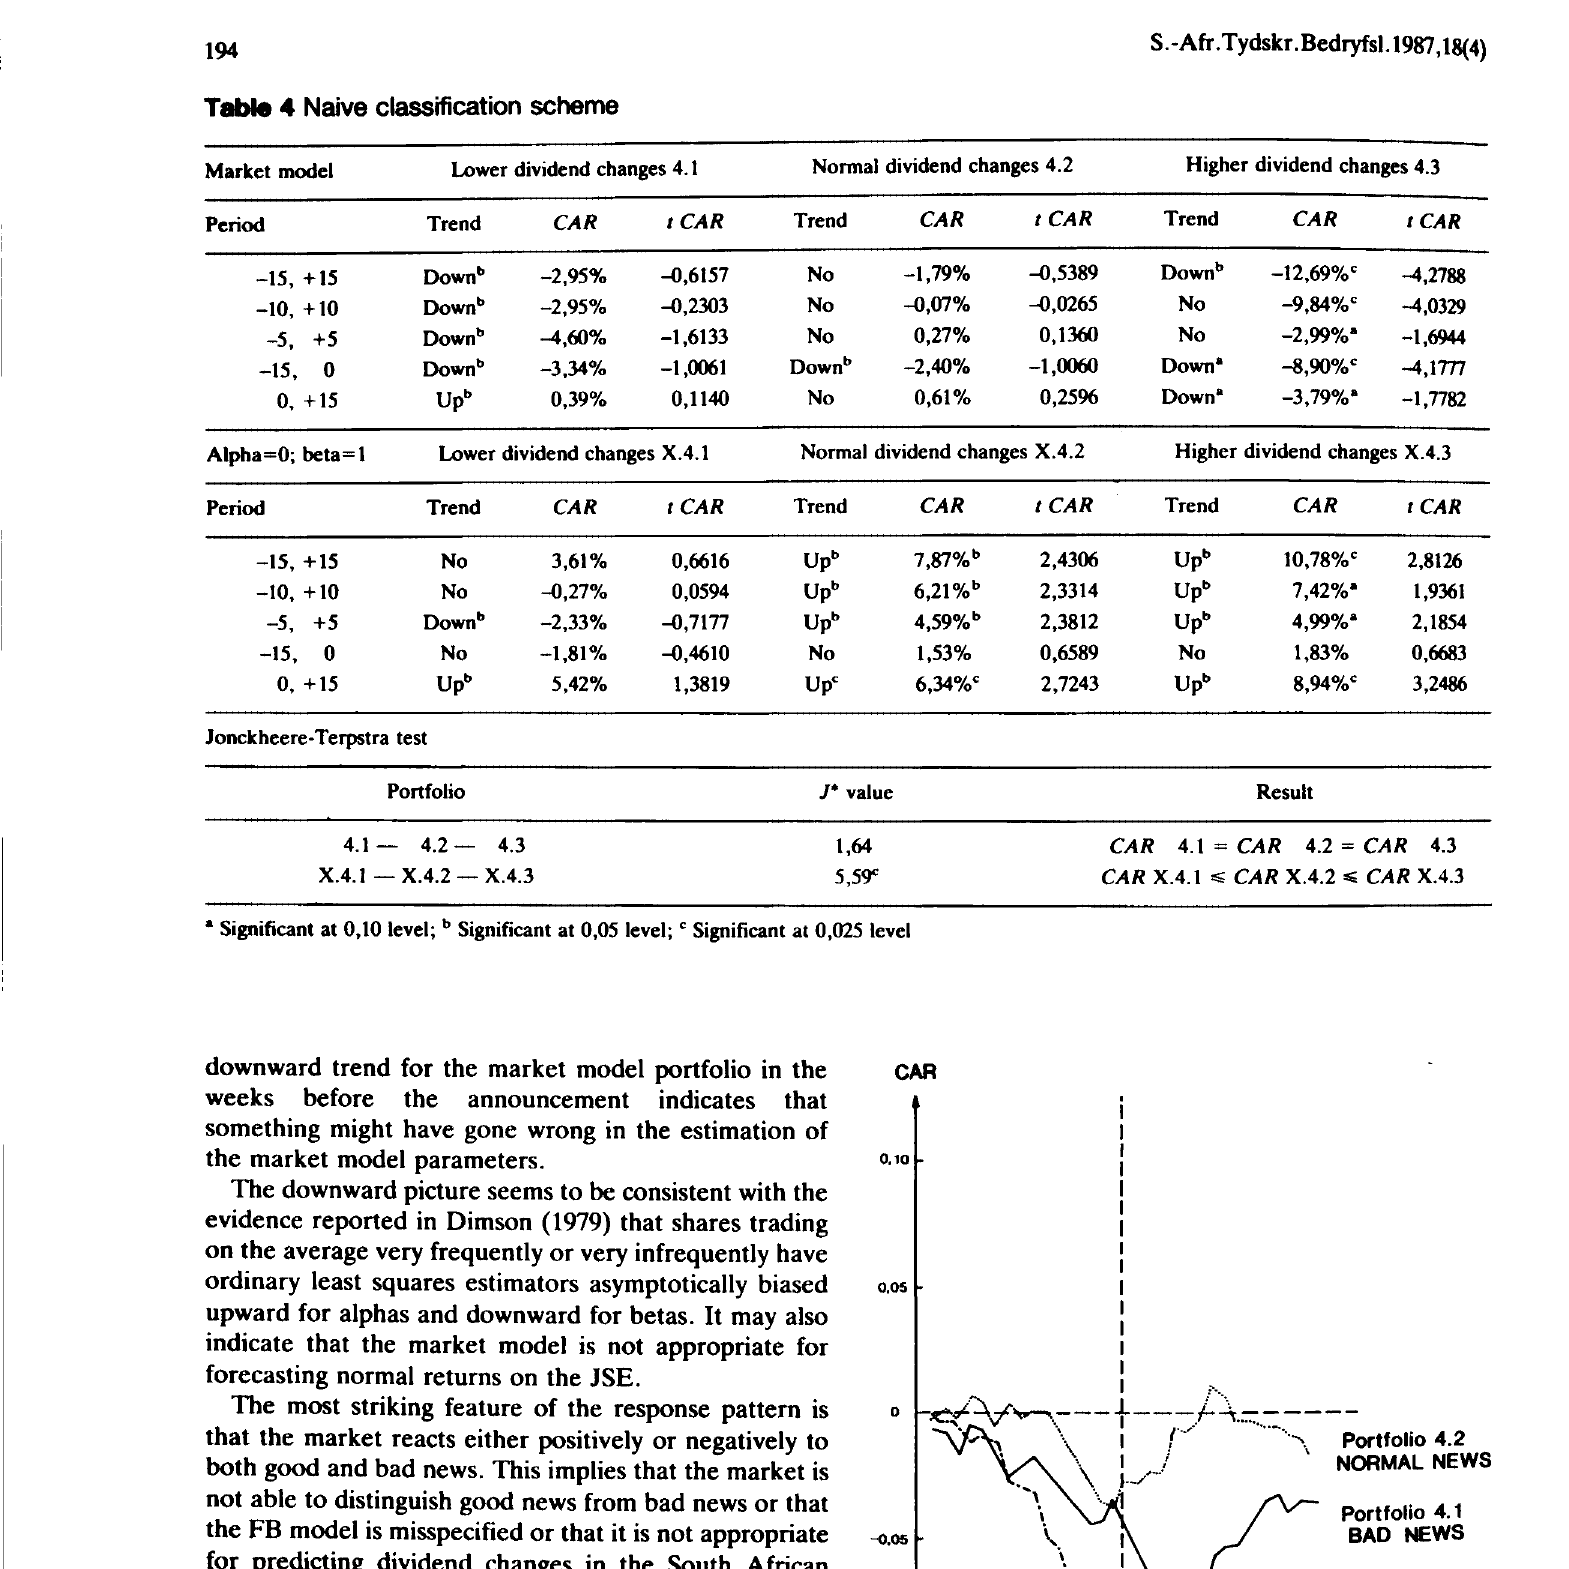
Table 4 Naive classification scheme Market model